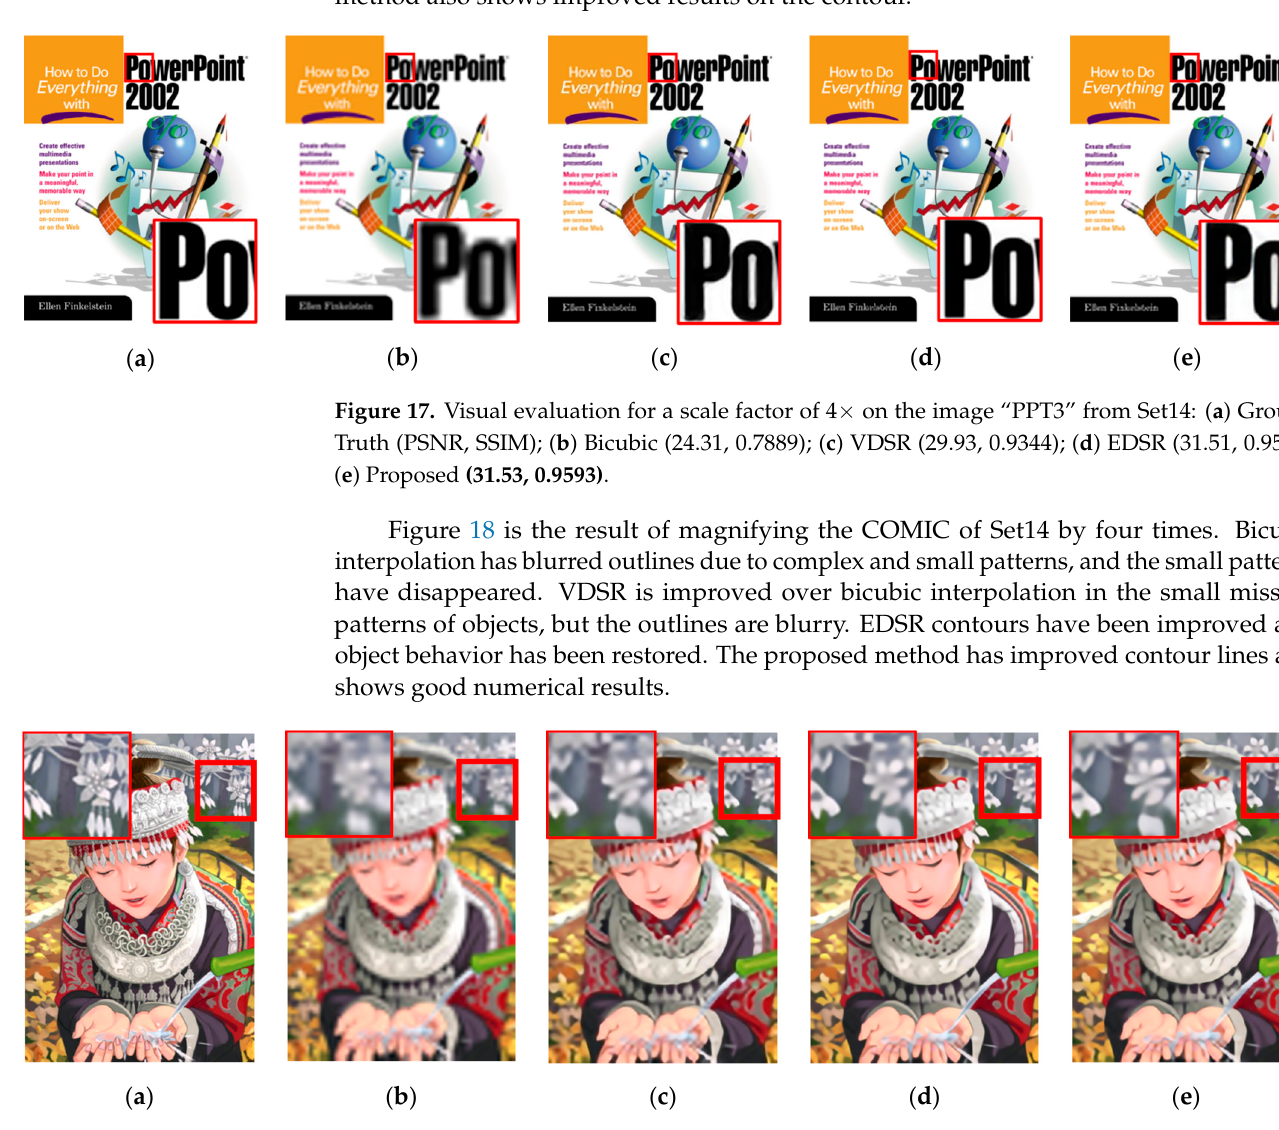
Truth (PSNR, SSIM); ( b ) Bicubic (24.05, 0.4994); ( c ) VDSR (27.26, 0.6988); ( d ) EDSR (28.42, 0.7606);